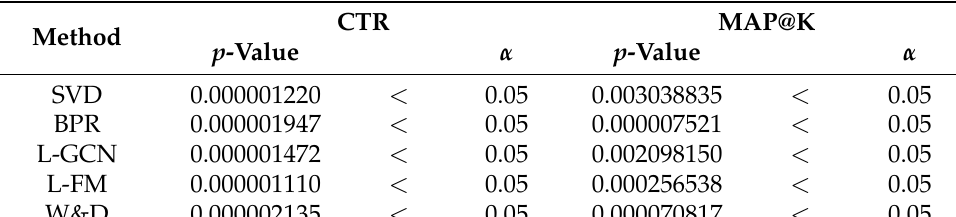
Table 3. The Wilcoxon test of the A/B experiments on the MovieLens dataset.